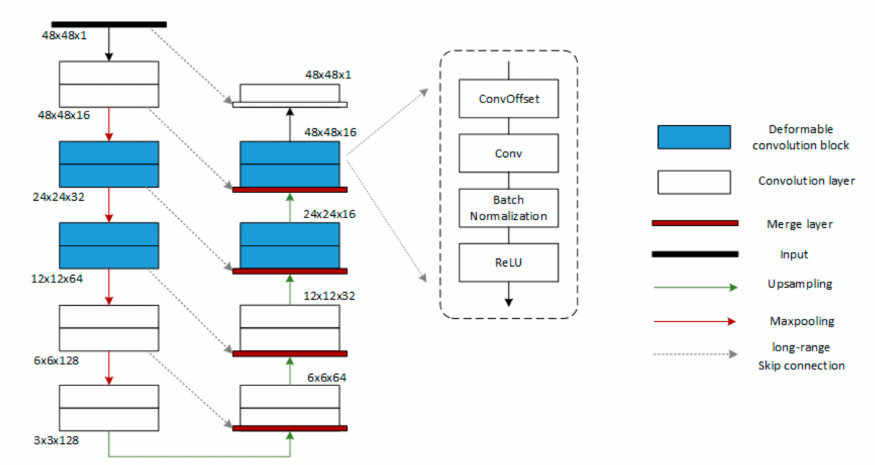
Figure 4. DUNet architecture with convolutional encoder and decoder based on U-Net architecture. Output size of feature map is listed beside each two